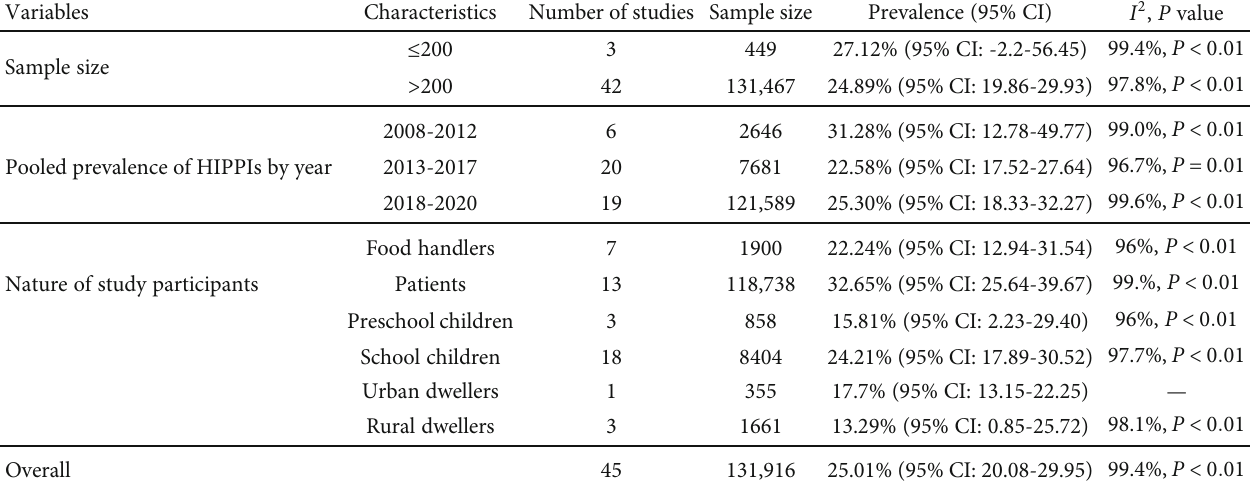
Table 2: Prevalence of HIPPIs in Ethiopia by